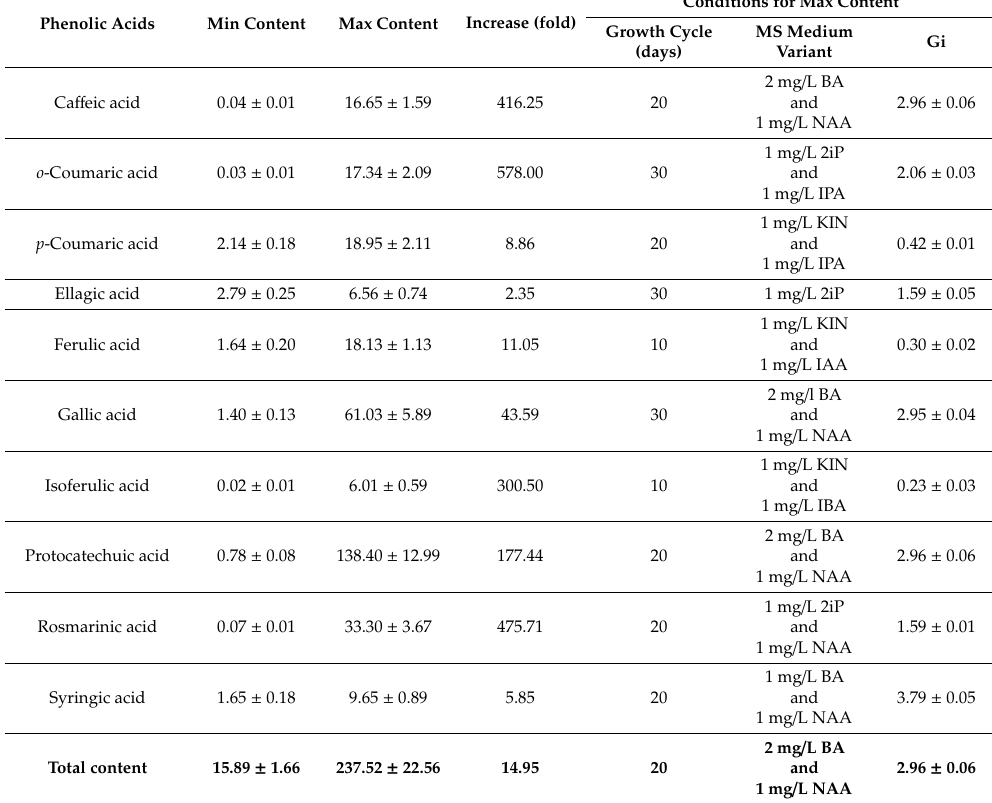
Table 2. The range of individual and total phenolic acid contents (mg / 100 g DW ± SD) dependent on duration of growth periods and composition of cytokinins and auxins in the MS media variants in agar microshoot cultures. Values represent the mean ( ± SD) of five samples ( n = 5). Table is corresponding with Tables